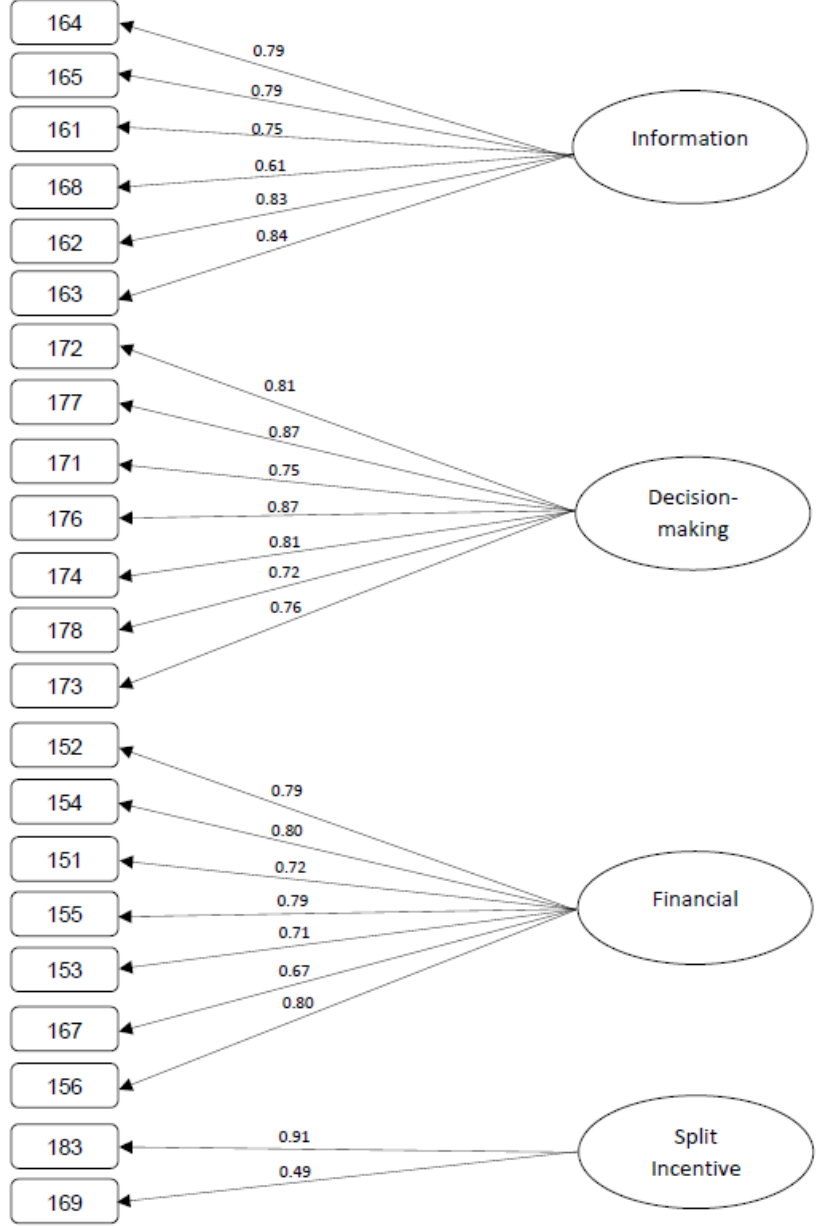
Figure 2. Empirically tested CFA model. Note: The squares denote the observed variables with item numbers listed in Table 3 whereas the ellipses denote the latent factors.